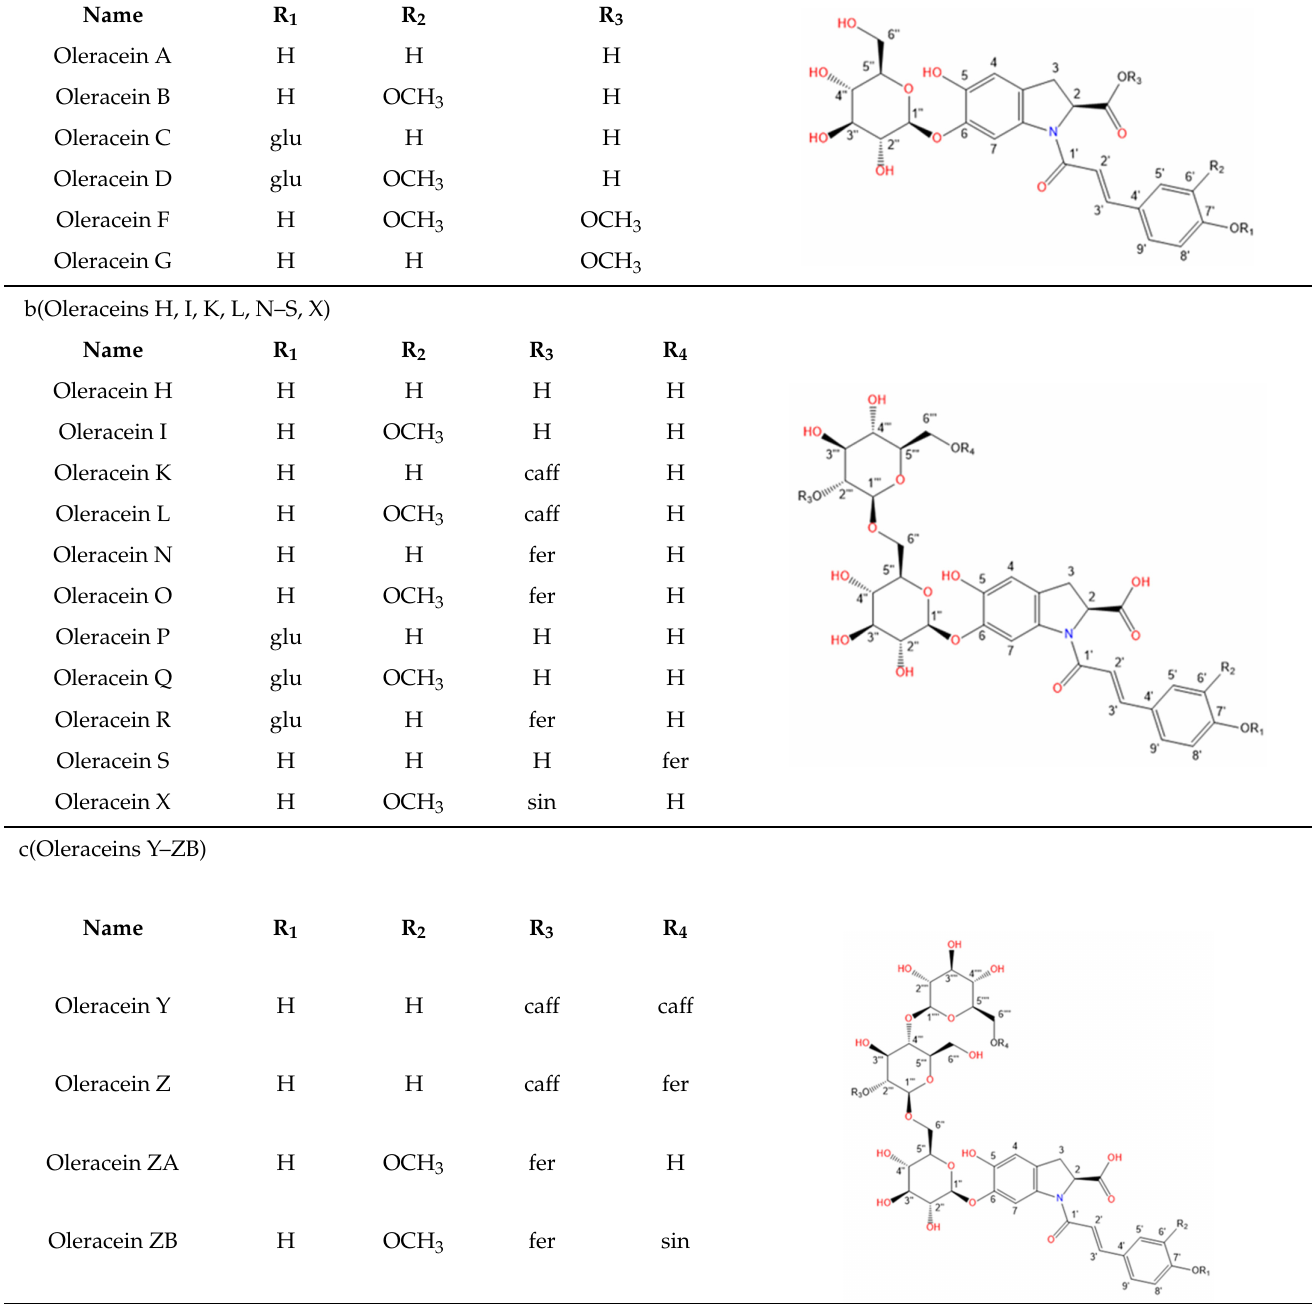
Table 1. Known isolated and characterized oleraceins in the literature: A–D [29]; oleraceins E, T, U, V, W—not included; F and G [30]; H, I, K, L, N–S [27]; X–ZB [12]. a(Oleraceins A–D, F,